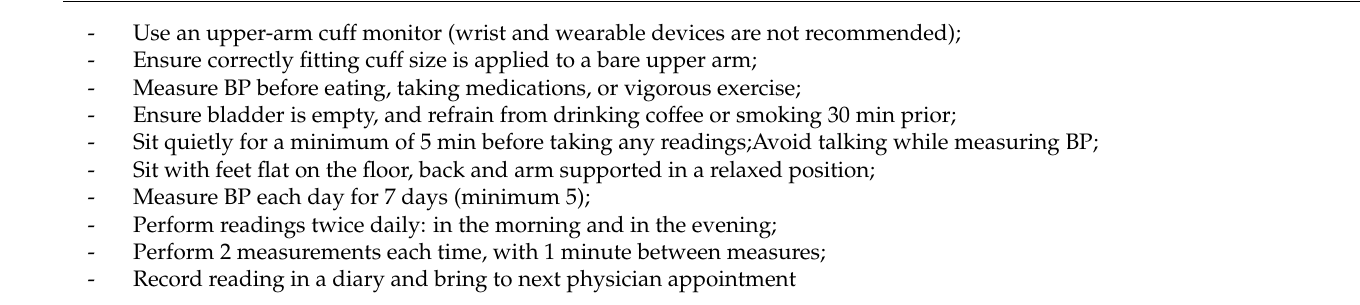
Table 2. Summary of key recommendations for the best practice measurement of home